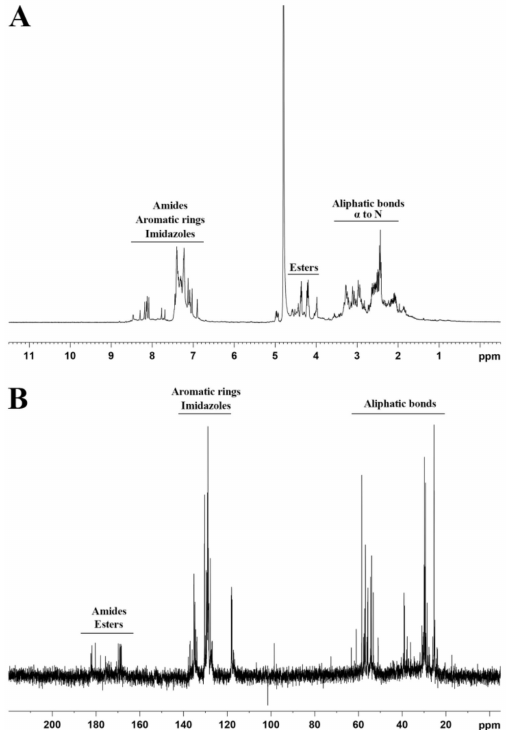
Figure 2. Proton ( A ) and carbon ( B ) NMR spectra of as-obtained P(EFH-PLLA)